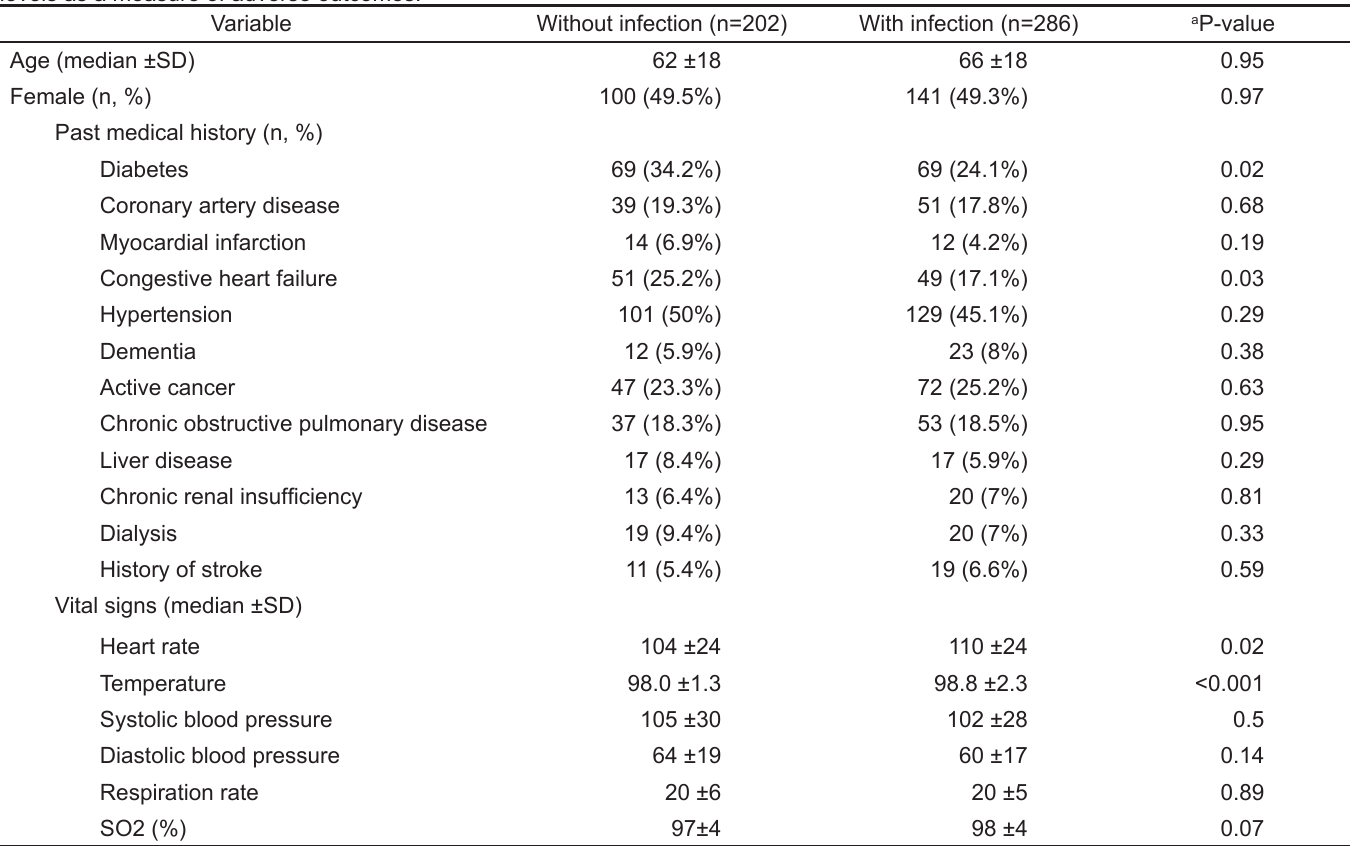
Table 1. Population characteristics of emergency department patients with abnormal vital signs in a study analyzing serum lactate levels as a measure of adverse